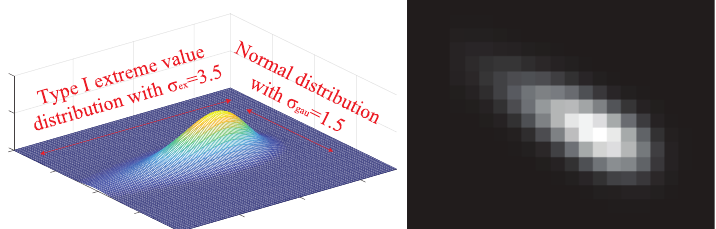
Figure 2. A view of the target model and its projection on the image plane.